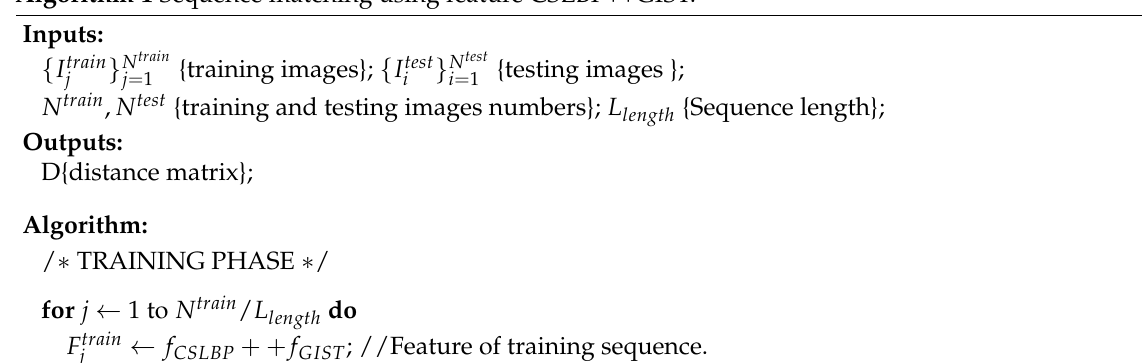
Algorithm 1 Sequence matching using feature